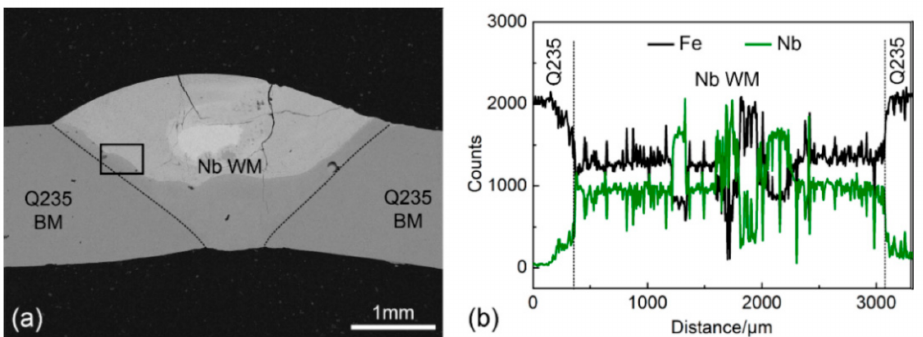
Figure 2. ( a ) The cross section of Fe–Nb welded joint; ( b ) EDS line scanning across the weld. BM: base metal; WM: weld